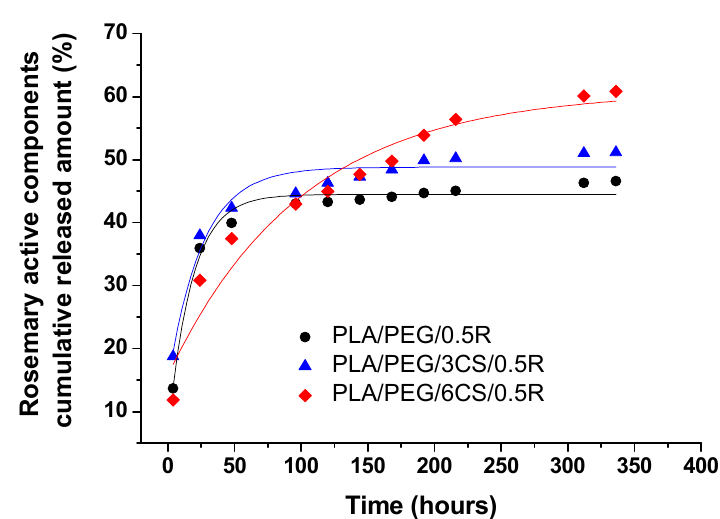
Figure 7. Release profiles of the active components from rosemary powdered ethanol extract into 50% ethanol solution as a food simulant. Table 6. Kinetic parameters of the bioactive compounds release from plasticized PLA based materials containing CS and rosemary